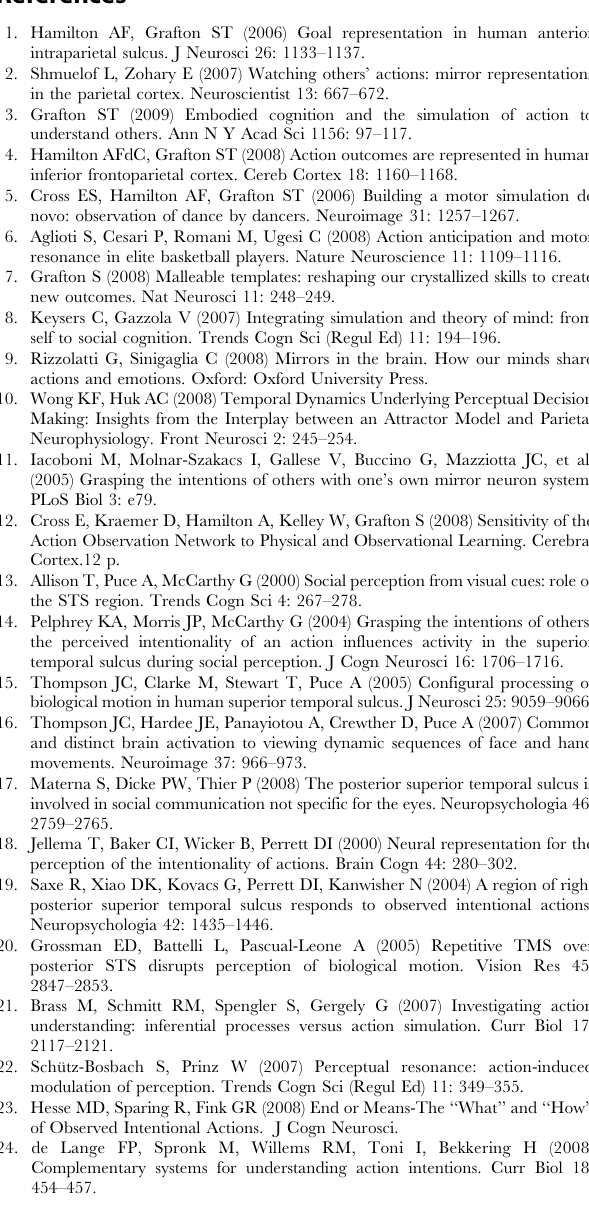
Video S1 Example of one of our stimuli. This video 1 shows a hand grasping a hairdryer to transport